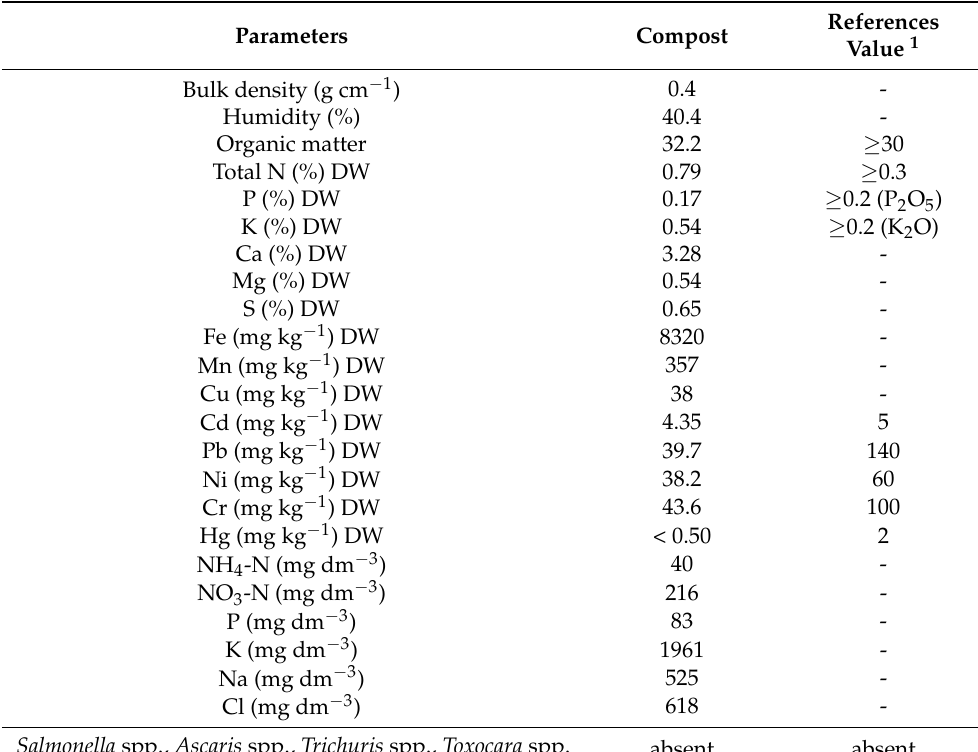
Table 4. Properties of final